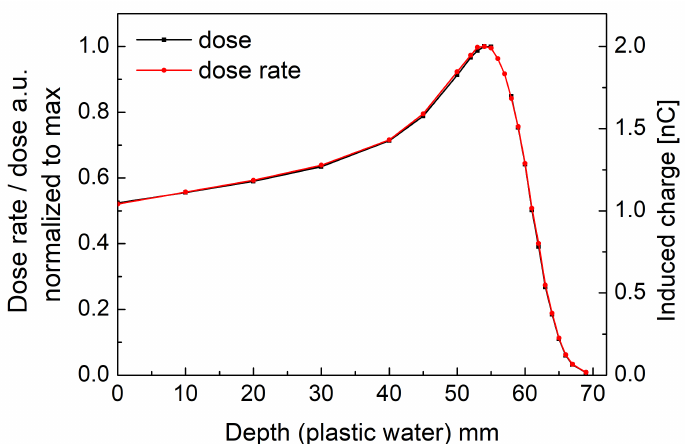
Figure 5. Comparison between measured induced current (dose rate profile) and measured induced charge (dose profile) for the 230 MeV proton beam degraded to 89 MeV.